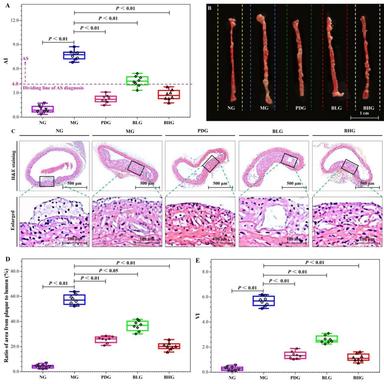
Effect of BQPS on the formation of atherosclerotic plaques and stability. AI values of ApoE−/− mice serum (A). Aortic appearance of ApoE−/− mice (B). Representative image of H&E staining of the aortal cross section of ApoE−/− mice (C). Ratio of area from plaque to lumen (D). VI values of ApoE−/− mice aortas (E).